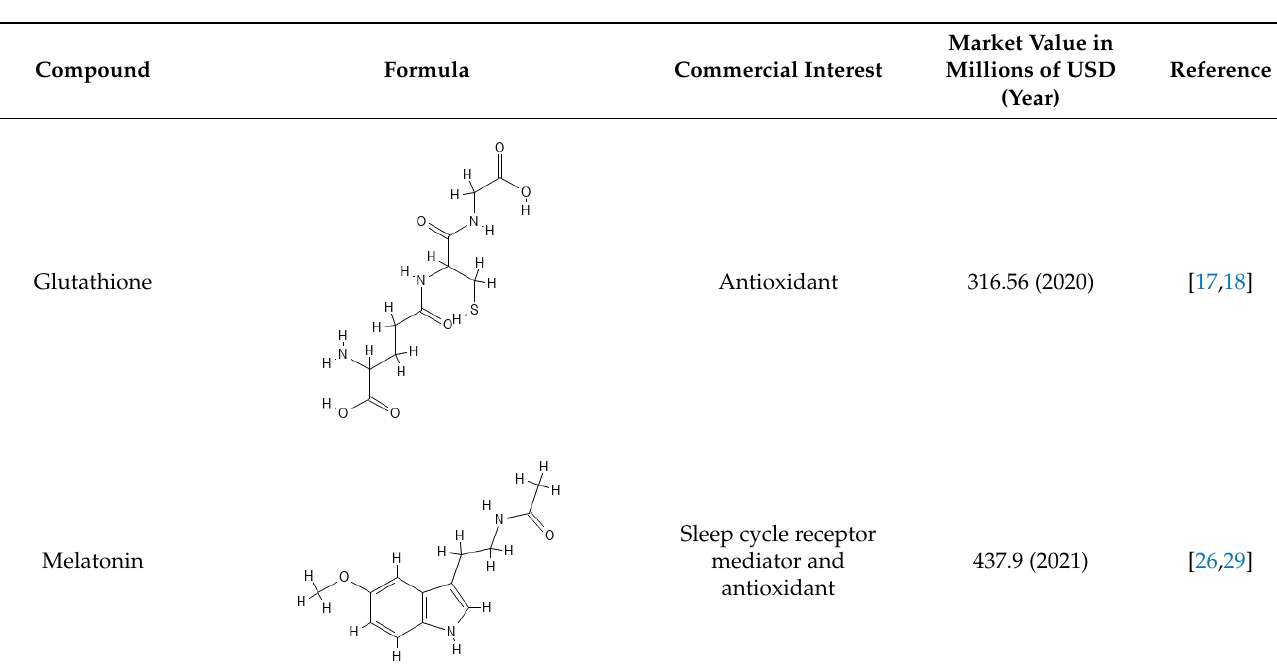
Table 1. Bioactive compounds produced by different nongenetically modified yeasts, their commercial interest, and market value.